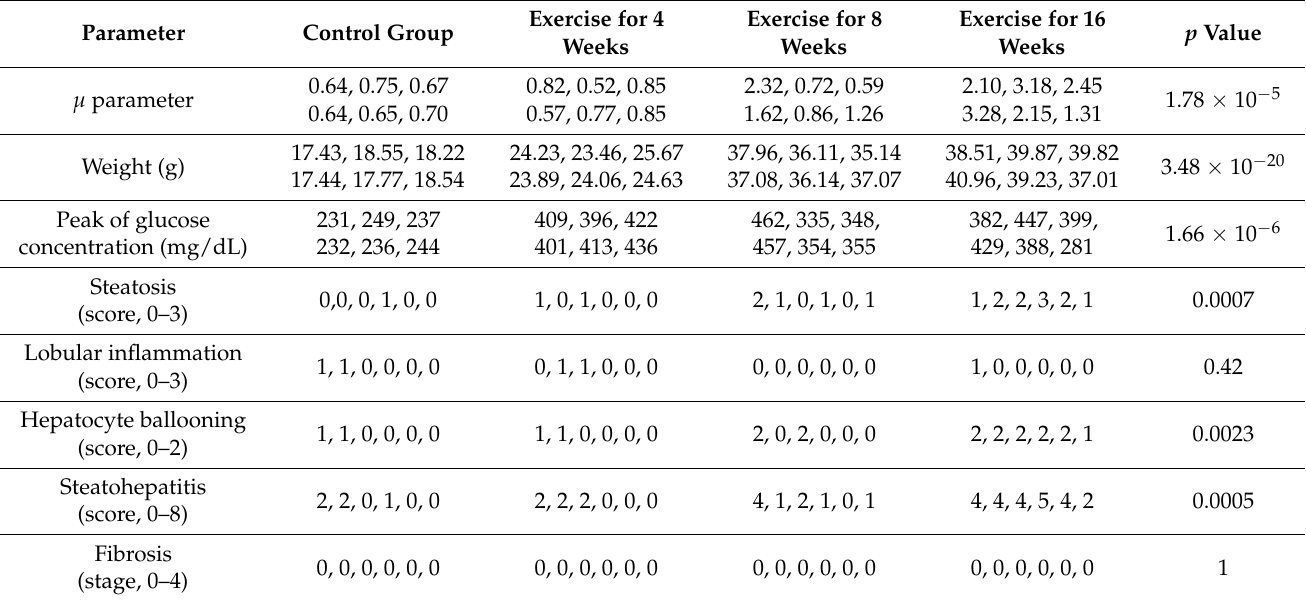
Table 2. Changes in steatosis, steatohepatitis, and fibrosis in the exercise group (the normality test failed, and thus ANOVA on ranks was